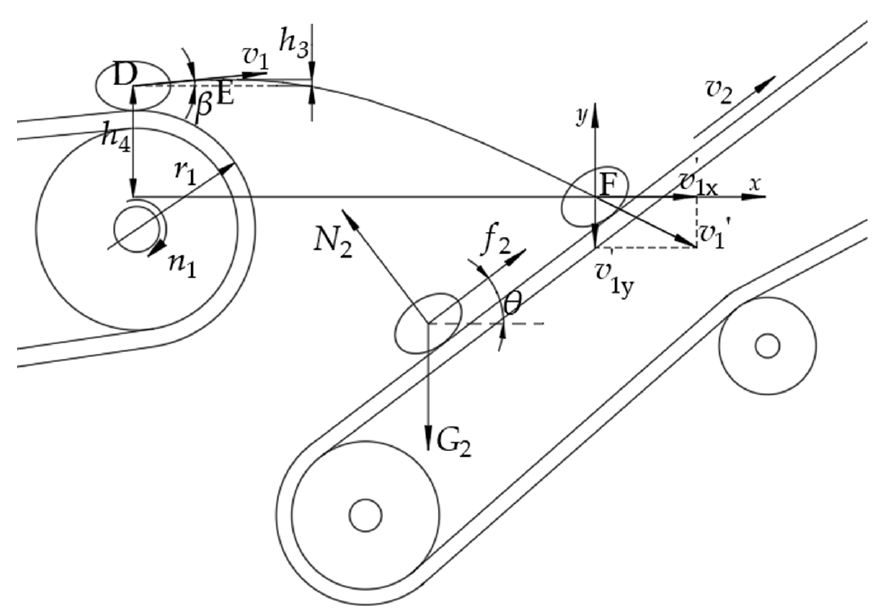
Figure 7. Force and motion analysis of the potatoes as they are transferred by the lifting chain of the digging–lifting device to the potato–plastic-film separation digging–lifting device to the potato–plastic- fi lm separation device.